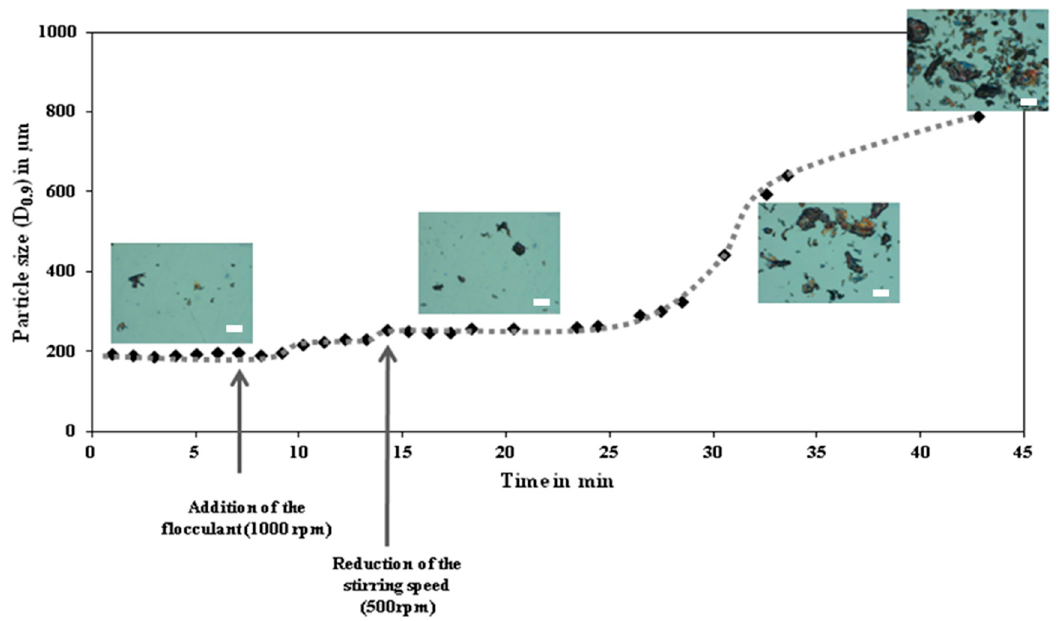
Figure 16. Evolution of particle size (D 0.9 ) as function of time with different concentrations of flocculant ( w / w ) 0.01% (top) and 0.1% (bottom) based on the concentration of microplastics. The scale bars in the inserts represent 100 μ m.